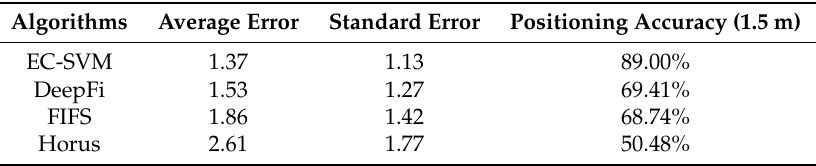
Table 1. Comparison of algorithm positioning performance.